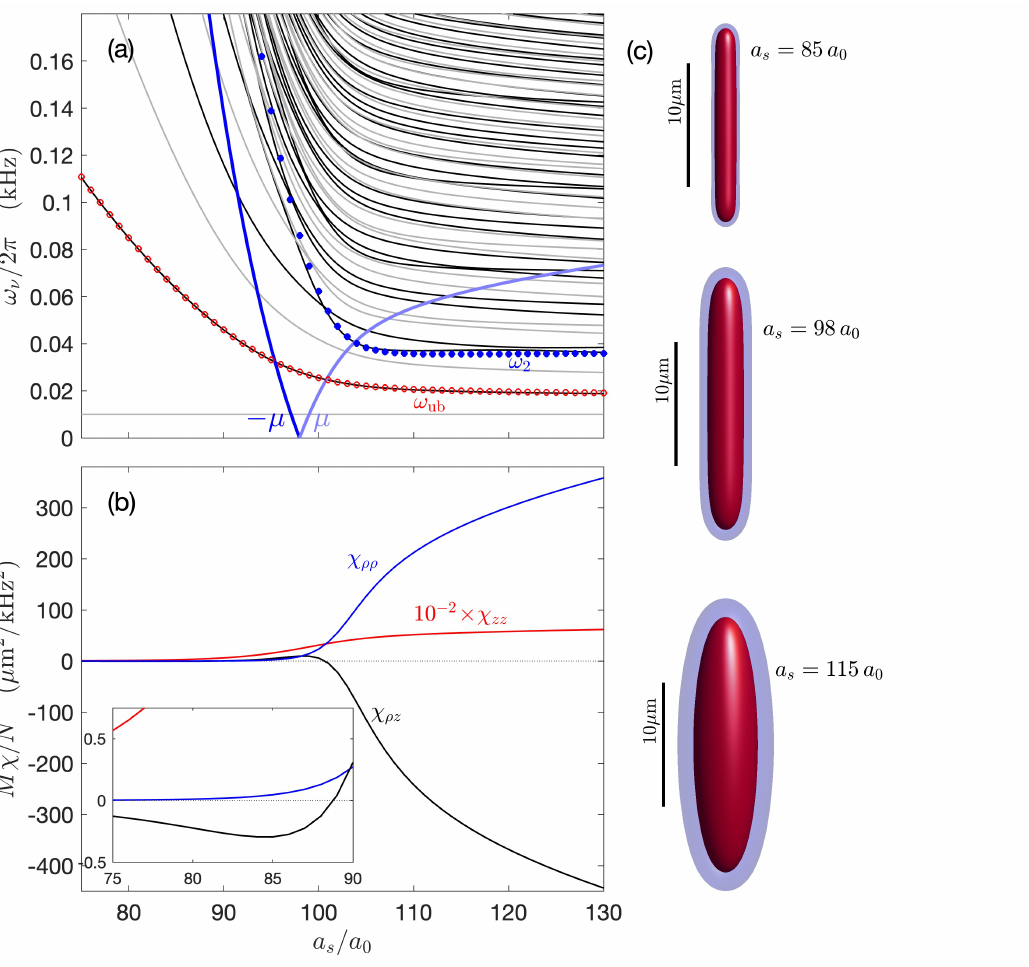
Figure 3. Trapped quantum droplet as a function of s-wave scattering length a s . ( a ) Results from numerical solution of the BdG equations for the m = 0 excitations that are even (black lines) and odd (grey lines). The approximate result ω ub obtained from (15) (red circles) and the excitation frequency estimate ω 2 from Equation (23) (blue circles). The energy scales ± µ are shown for reference (blue lines). ( b ) The static polarizabilities χ zz , χ ρ z and χ ρρ . ( c ) Density isosurfaces of droplet states for various a s values as labelled. Isosurfaces shown for 10 18 m − 3 (blue) and 10 19 m − 3 (red). Results for N = 10 4 164 Dy atoms using a dd = 130.8 a 0 and ( ω x , y , ω z ) /2 π = ( 20,10 )